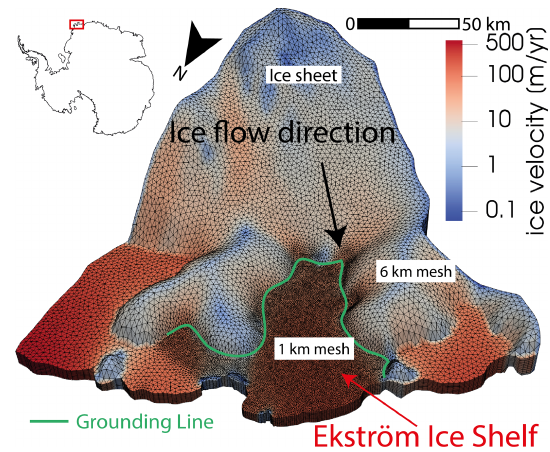
Figure 2. Model domain of Elmer/Ice in 3D including numerical mesh of Ekström Ice Shelf catchment, East Antarctica, with ice ve- locity in the